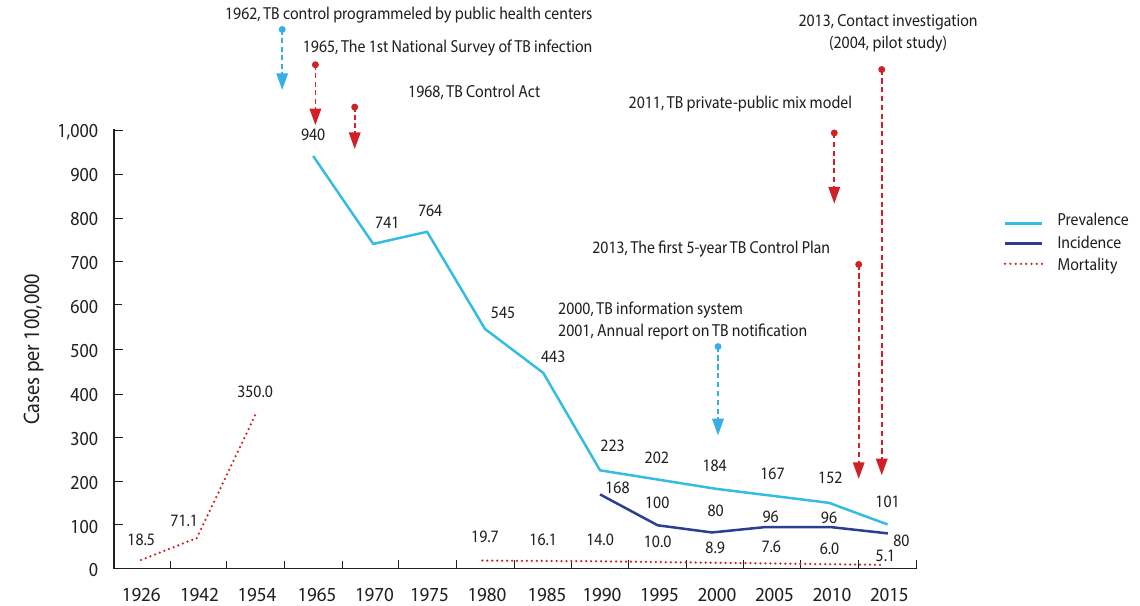
Figure 1. Annual prevalence, incidence, and mortality rate of tuberculosis (TB). Adapted from Cho KS. Health Soc Welf Rev 2017;37:179-212 [3], with permission of the Korea Institute for Health and Social